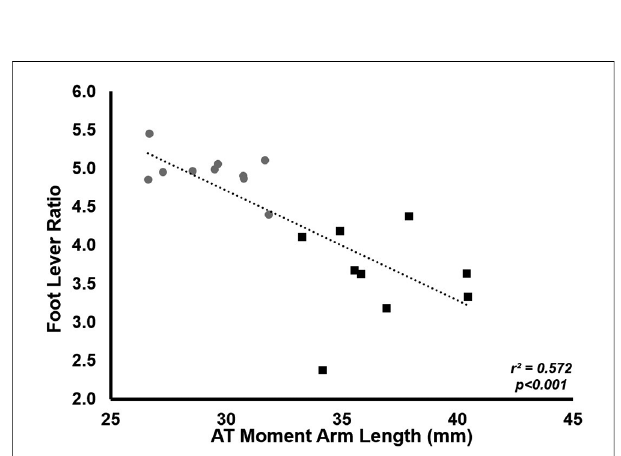
FIGURE 2 The relationship between foot lever ratio and AT MA . Grey circles represent the SHORT AT MA group, while black squares represent the LONG AT MA group. Across all participants, a longer AT MA was associated with a lower foot lever ratio.